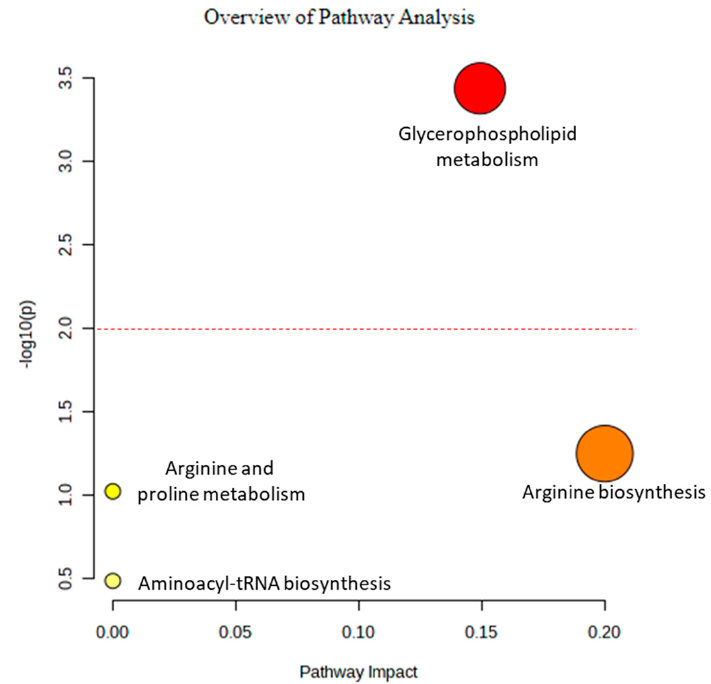
Figure 6. A detailed analysis of the pathways of significantly altered metabolites after metronidazole exposure.